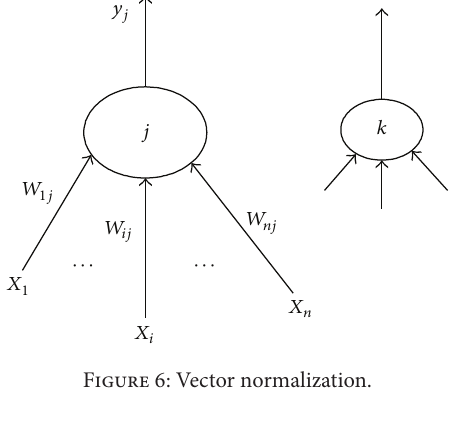
Figure 6: Vector normalization.